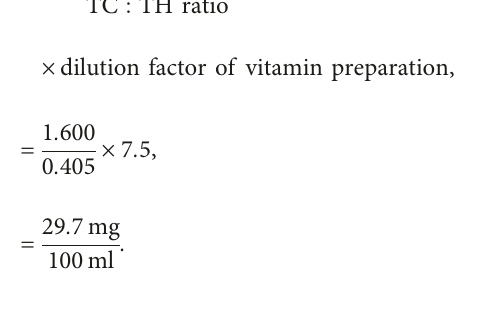
Figure 3: Yield of TC as a function of reaction